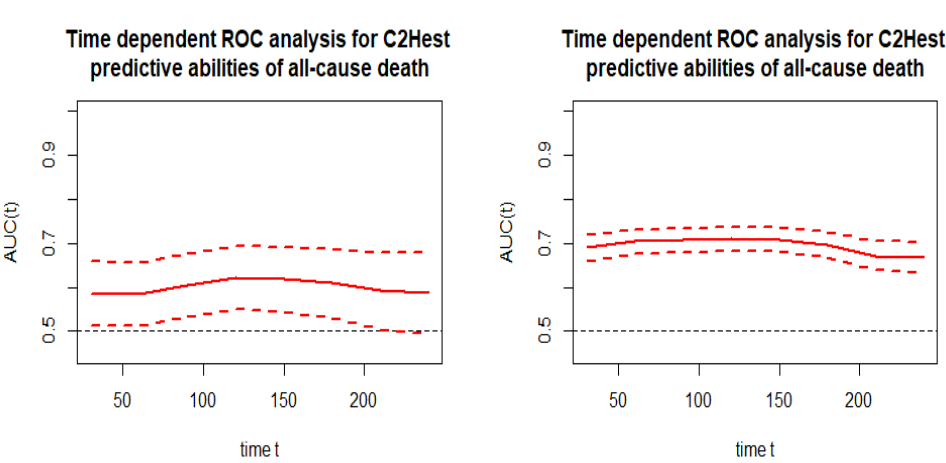
Figure 2. Time-dependent ROC analysis for the C 2 HEST predictive abilities of all-cause death in both study